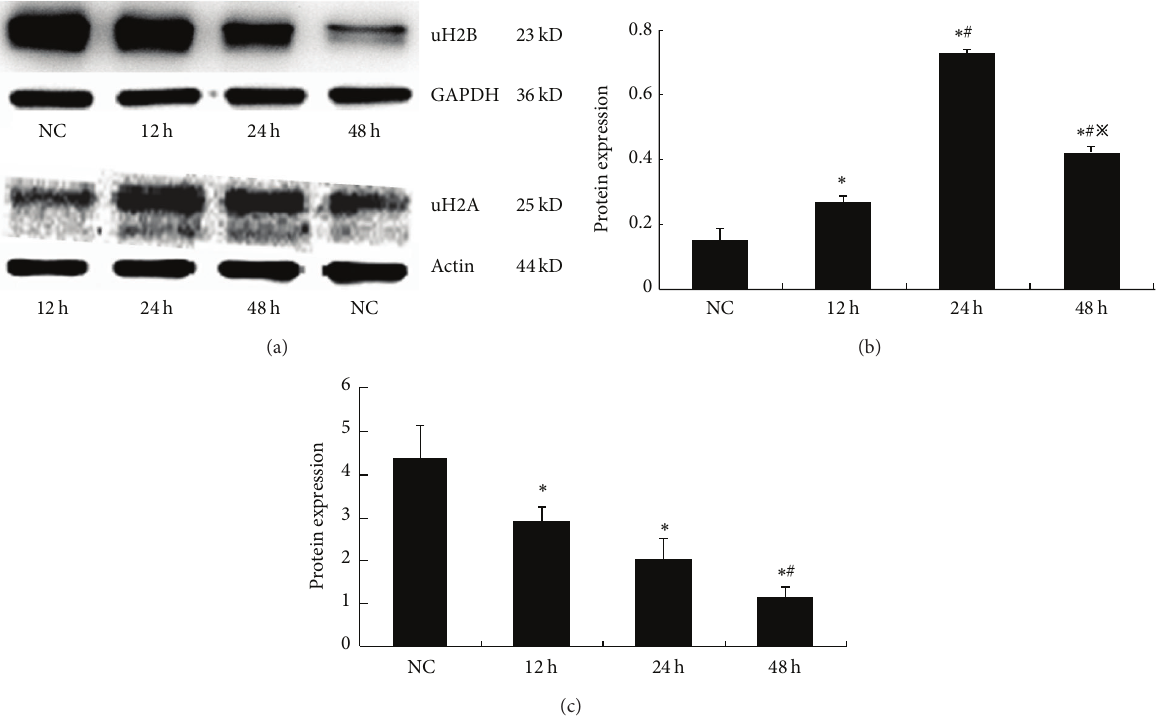
Figure 4: The expression of histone H2A and H2B ubiquitination in GMCs induced by 30mmol/L glucose at various times determined using Western blot. (a) Compared to the NC group, uH2A expression increased after stimulation with 30mmol/L glucose after 24 hr, but the uH2B expression decreased over time. (b) The gray graph shows the relative statistical values for uH2A protein expression at various time points for each group. The expression of uH2A was increased at 24 h sharp. ∗ 𝑃 < 0.01 versus NC group, # 𝑃 < 0.05 versus 12h, and n 𝑃 < 0.05 versus 24h. (c) The gray graph shows the relative statistical values for uH2B protein expression at various time points for each group. And the change of uH2B expression was a time dependent reduction. ∗ 𝑃 < 0.01 versus NC group, # 𝑃 < 0.05 versus 12h, and n 𝑃 < 0.05 versus 24